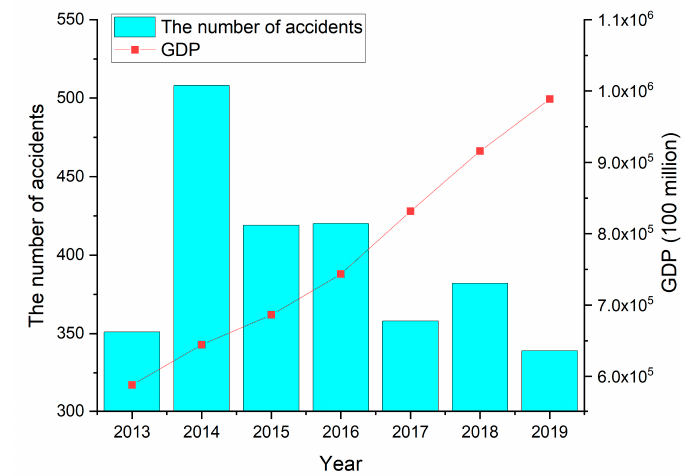
Figure 1. Distribution of accidents from 2013 to